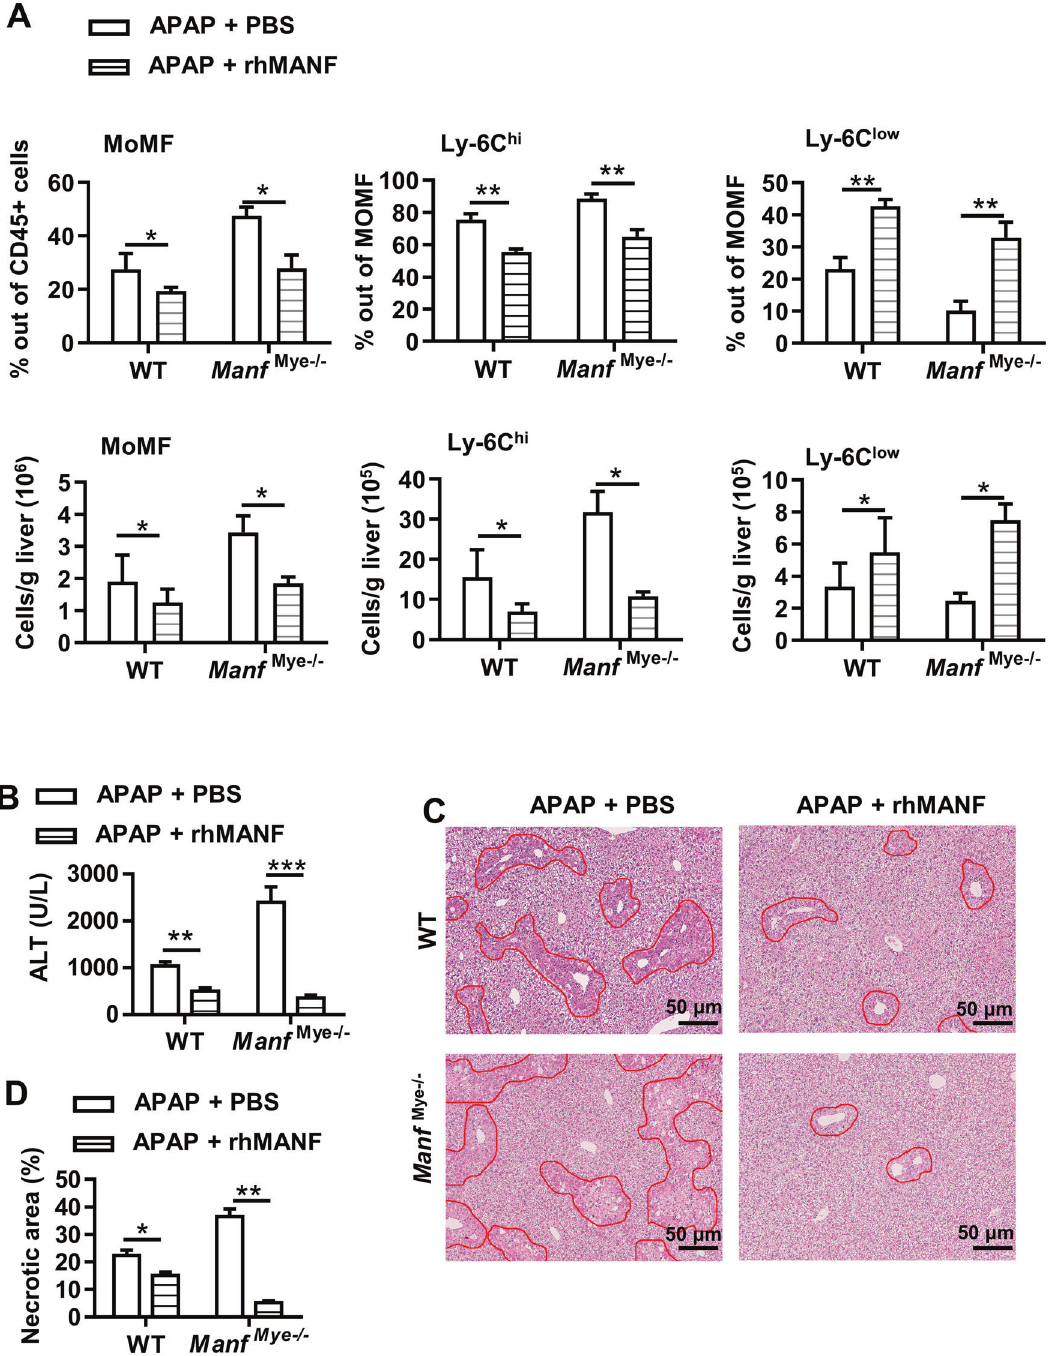
Fig. 4 The rhMANF enhances the restorative macrophage phenotype in vivo and accelerates liver injury resolution. WT mice and Manf Mye-/- mice were intravenously injected with rhMANF (1.5 mg/kg) at the same time as APAP administration. Mice were sacri fi ced at 48 h after APAP administration. A The percentages and numbers of hepatic MoMFs, Ly-6C hi expressing MoMFs, and Ly-6C low expressing MoMFs were quanti fi ed by fl ow cytometric analysis. B Serum ALT activities were determined. C Representative H&E-stained liver sections. n = 5 – 7 sections/mouse. D Necrotic areas in the liver were quanti fi ed by ImageJ software. Data are presented as mean ± SD, n = 5 – 7 mice per group, 3 independent macrophage phagocytosis. Our results showed that the p38 MAPK inhibitor decreased rhMANF-induced phagocytosis-related gene expression and phagocytosis of apoptotic hepatocytes in mouse peritoneal macrophages (Fig. 7C, D). It is worth noting that